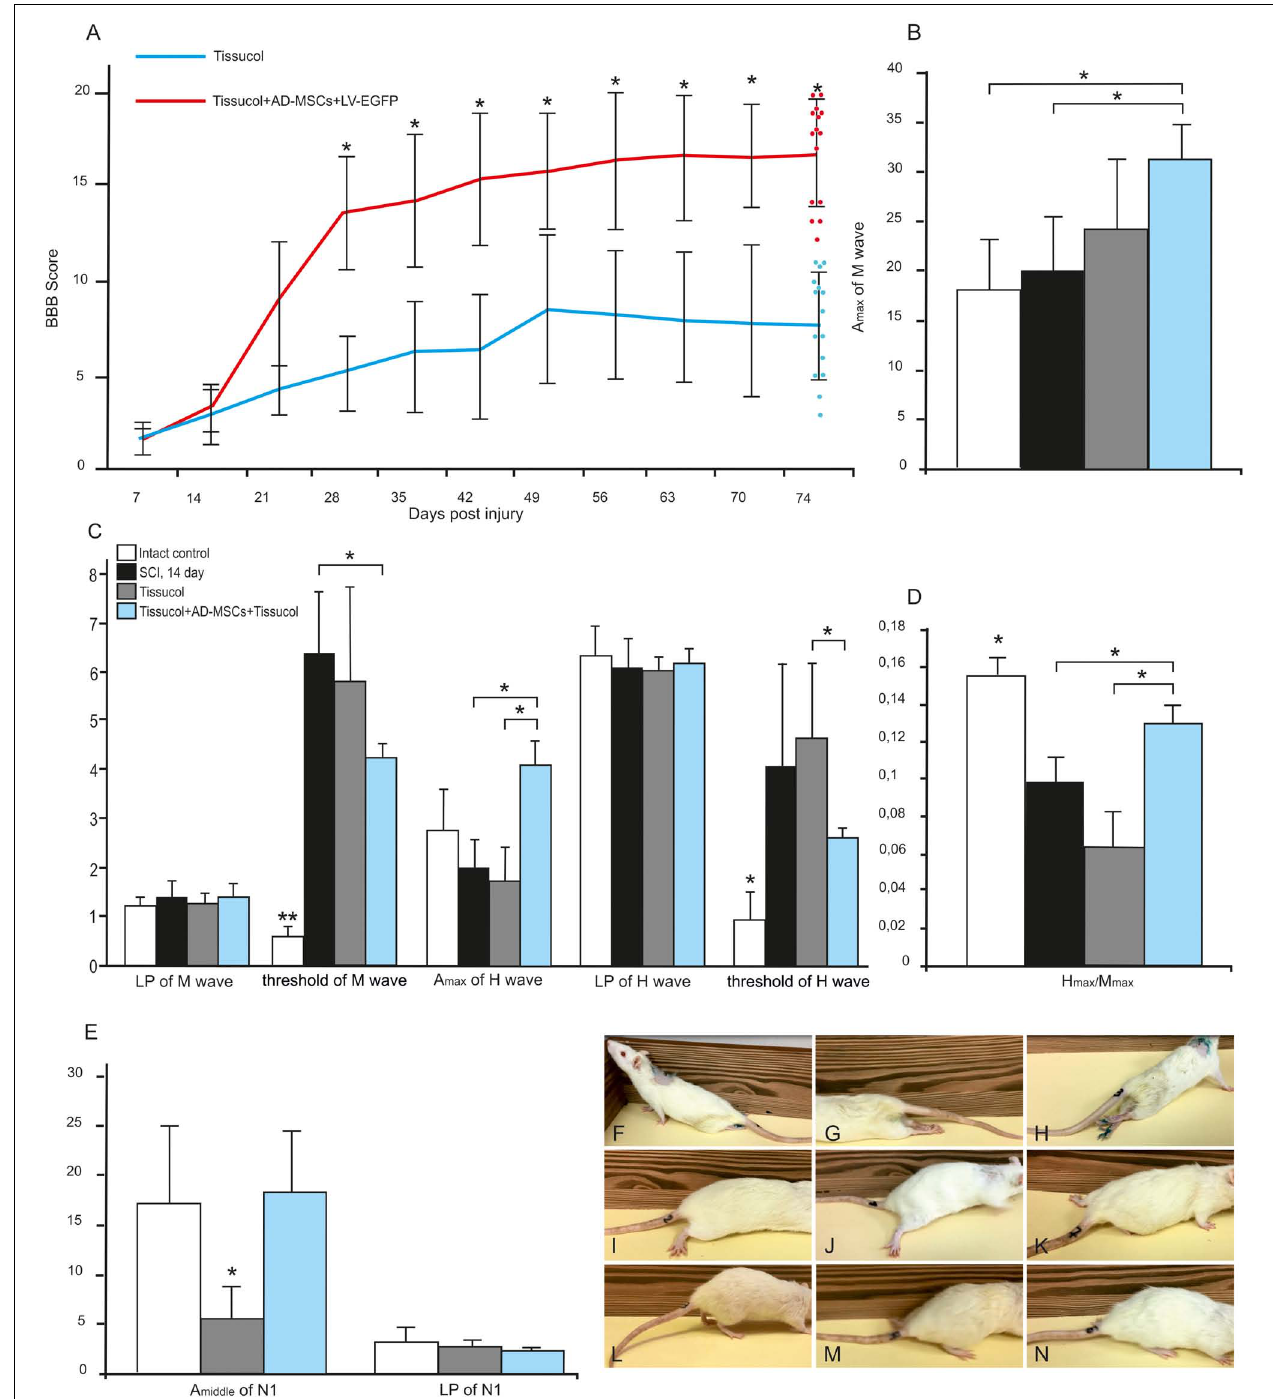
FIGURE 1 | Behavioral and electrophysiological studies after SCI in control and experimental groups. BBB locomotor scores of rats of the Tissucol (blue line) and Tissucol+AD-MSCs+LV-EGFP (red line) groups. The motor function scores were higher in Tissucol+AD-MSCs+LV-EGFP group than those in the Tissucol group on week 11 after injury, with significant differences for at least within 8 post-injury weeks. ∗ P < 0.05, one-way ANOVA followed by a Tukey’s post hoc test (A) . Amax of M-wave (B) , Amax of H-wave, LP and a threshold of M- and H-waves (C) , H/M wave amplitude ratio (D) after SCI in the experimental groups. ∗ P < 0.05, ∗∗ P < 0.01, one-way ANOVA followed by a Tukey’s post hoc test. Middle amplitude and LP of lumbar N1 after SCI in the experimental groups (E) . Video images of a spinal cord-injured rats showing absent or slight movements at day 7 after SCI (F–H) , extensive movement of joints with no weight support steeping (I,J) and occasional dorsal stepping (K) in Tissucol group at day 74 after SCI, two step cycles with weight supported plantar stepping and coordination between the forelimb/hindlimb and tail consistently up in Tissucol+AD-MSCs+LV-EGFP group at day 74 after SCI (L–N) .